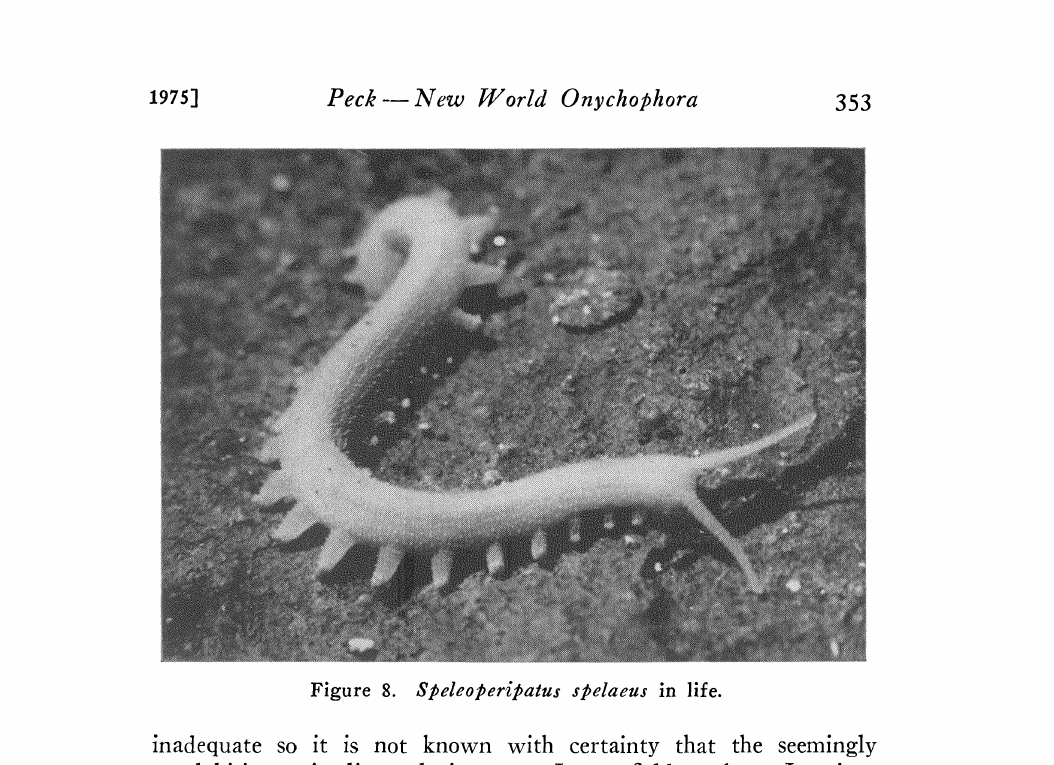
Figure 8. 81eleoperilatus spelaeus in